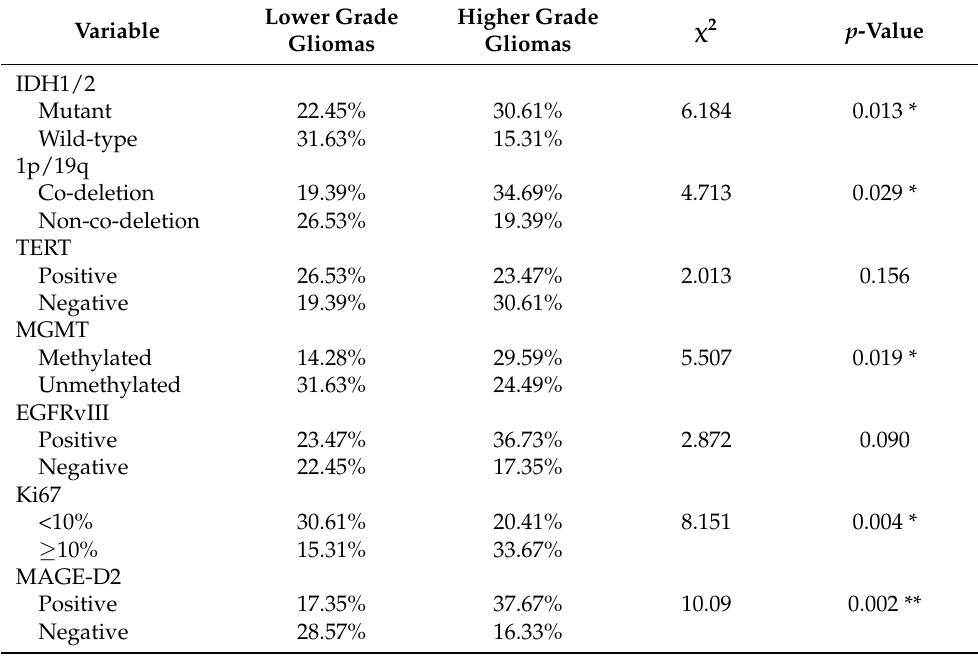
Table 2. Summary of molecular data of samples of included gliomas ( n = 98). Lower Grade Higher Grade Variable Gliomas